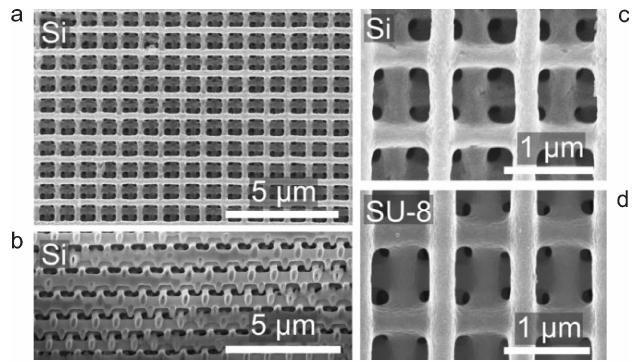
Figure 12. SEM images of a-Si:H woodpile photonic crystal using SU-8 template: ( a ) top view of the a-Si:H woodpile photonic crystal; ( b ) cross-sectional view of the a-Si:H photonic crystal; ( c , d ) close-up views of the replicated a-Si:H and original SU-8 woodpile structures. Reprinted with permission from [40], copyright 2006 WILEY-VCH Verlag GmbH & Co.